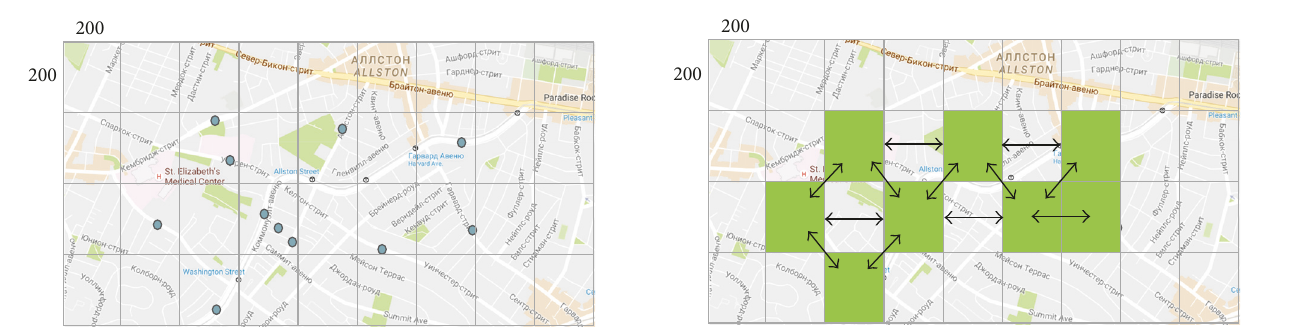
Figure 8: Grid after removing information about the devices from it, the probability of data transfer through which is small.